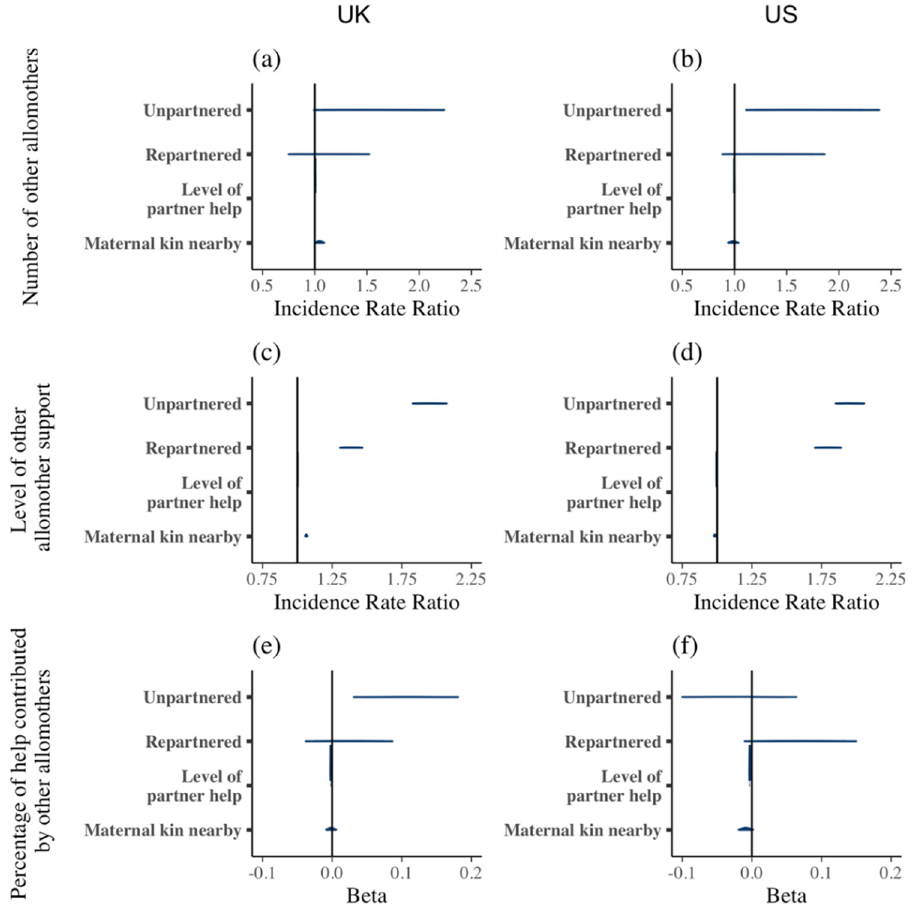
Figure 3. Plots showing the posterior distributions (95% credibility intervals) for the major predictors and control variables in the models for other allomother investment in each country, using the following measures: ( a , b ) number of other allomothers providing childcare; ( c , d ) total level of childcare help provided by other allomothers; and ( e , f ) percentage of total childcare help contributed by other allomothers. Reference category for unpartnered and repartnered women is partnered women; level of partner help and maternal kin nearby are entered as continuous predictors.